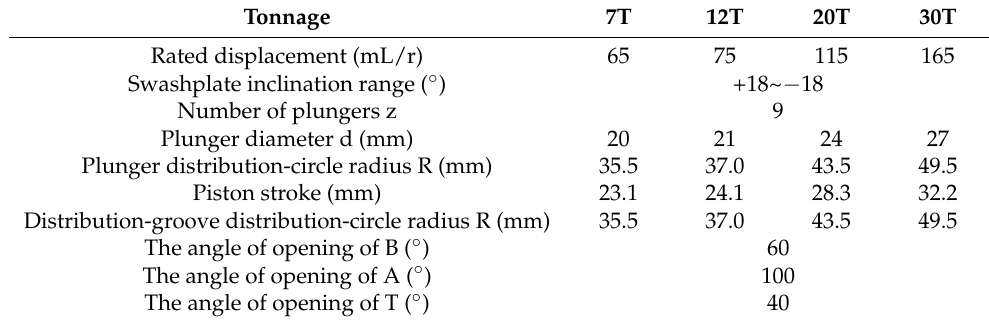
Table 6. VAPP Recommendation